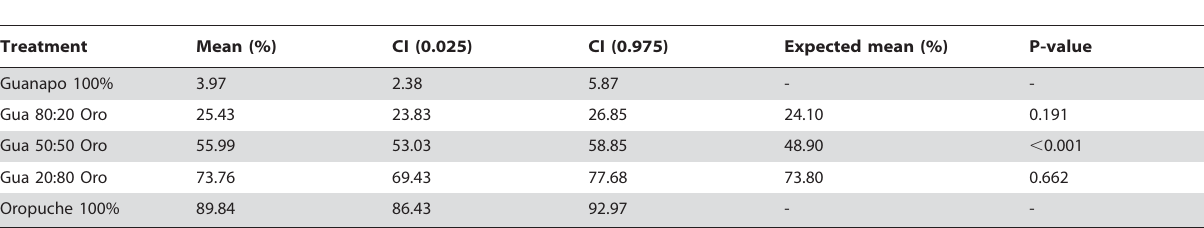
Table 3. Proportion and test results of SNPs in the mesocosm experiment.